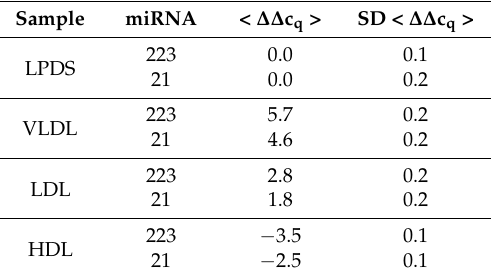
Table 1. miRNAs circulating in human serum and associated to lipoprotein particles. Sample